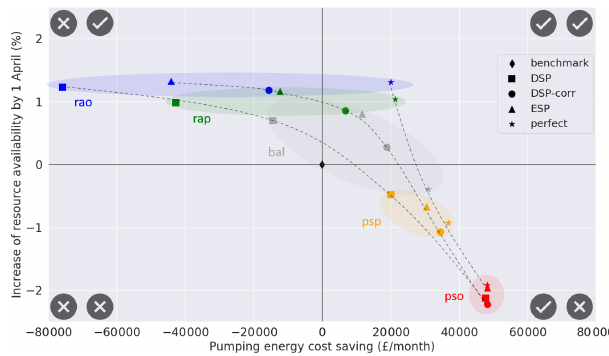
Figure 4. Post-evaluation Pareto fronts representing the average system performance improvement (over period 2005–2016) of the real-time optimization system during the pumping licence window (1 November–1 April) with respect to the benchmark (black dia- mond), using four forecast products: non-corrected forecast ensem- ble (DSP), bias-corrected forecast ensemble (DSP-corr), ensemble streamflow prediction (ESP) and perfect forecast. For each of the four forecast products, five scenarios of operational priorities are represented: resource availability only (rao; in blue), resource avail- ability prioritized (rap; in green), balanced (bal; in grey), pumping savings prioritized (psp; in green) and pumping savings only (pso; in red). For visualization purposes, the coloured circles group points under the same operational priority scenario, and the dashed lines link points using the same forecast product. The pumping energy cost is calculated as the sum of the energy costs associated with pumped inflows and pumped releases and the resource availability as the mean storage volume in both reservoirs (S1 and S2) at the end of the optimization period. Both objective values are rescaled with respect to the performances of the benchmark